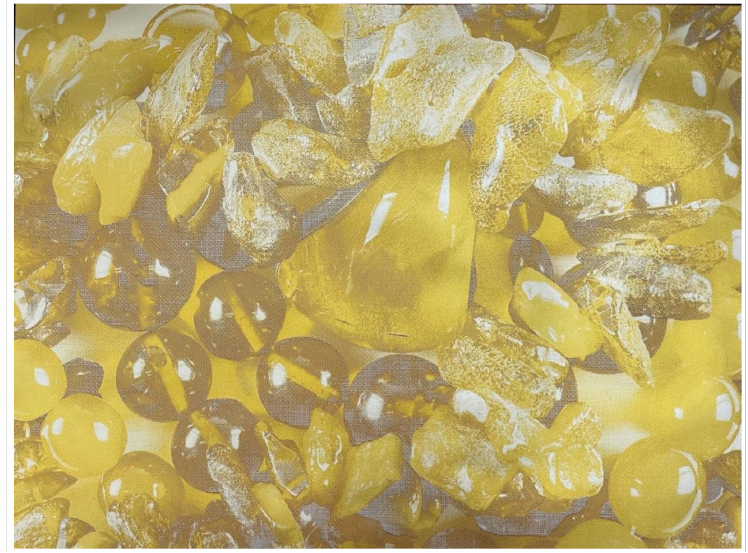
Figure A17. 25LPI, C = Pyrisma™ Ambercup Orange, B = Iriodin™ Solar Gold, M = Iriodin™ Platinum Gold, Y = Iriodin™ Icy White, printed dark to light, black Plike, film negative, print size: 600 mm × 450